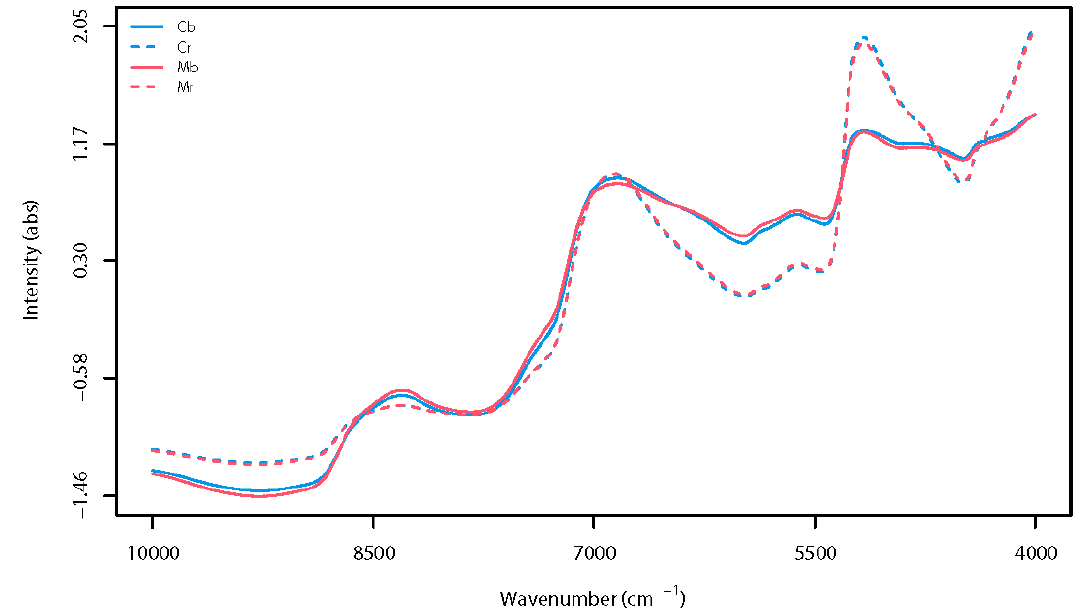
Figure 3. Mean absorbance spectra for raw Marrone chestnut (Mr), raw Sweet chestnut (Cr), boiled Marrone chestnut (Mb), and boiled Sweet chestnut (Cb). Spectral pre-treatment consisted of the Standard Normal Variate scatter correction, followed by the Savitzky-Golay noise filter of first polynomial order with 15 smoothing points.